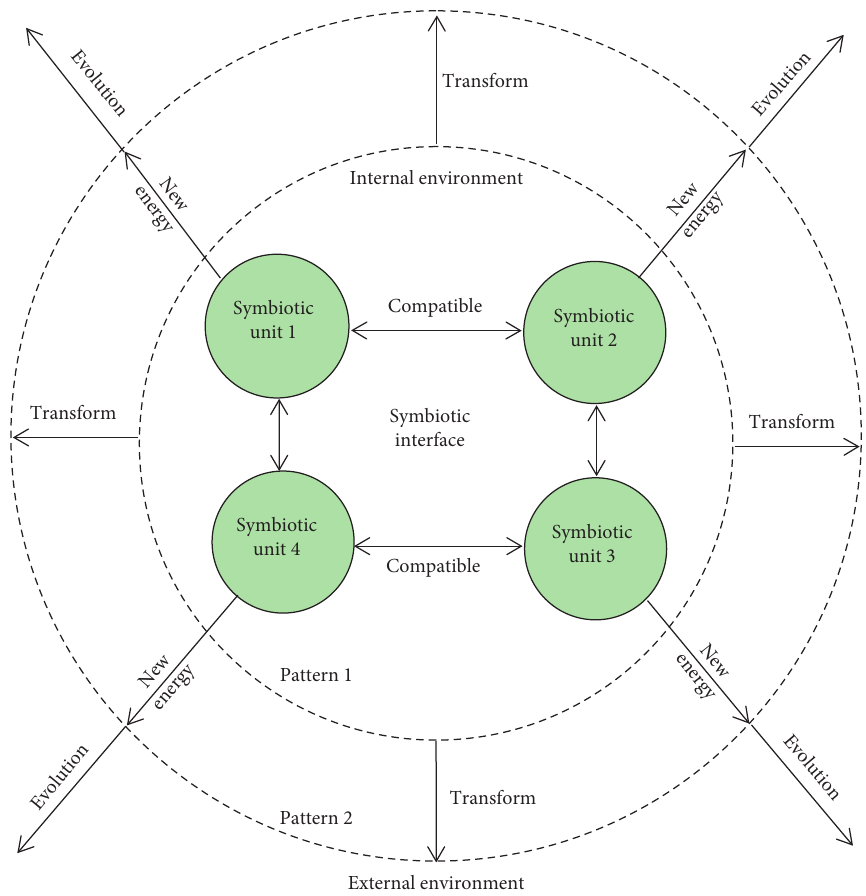
Figure 1: Symbiosis evolution of symbiotic units. The symbiotic units exchange energy and information through quality parameters on the symbiotic interface, and the new energy generated changes the symbiosis pattern and gradually realizes the symbiosis